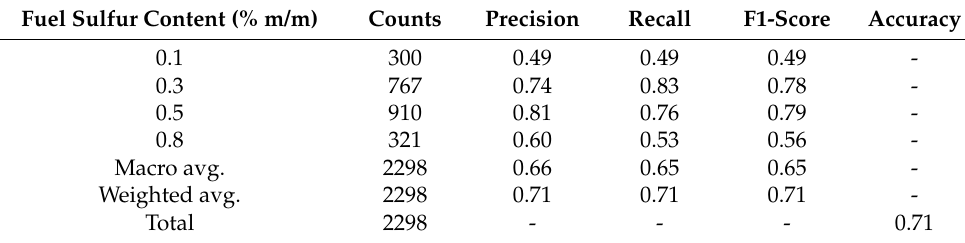
Table 5. Model evaluation report for 330 nm. Fuel Sulfur Content (%